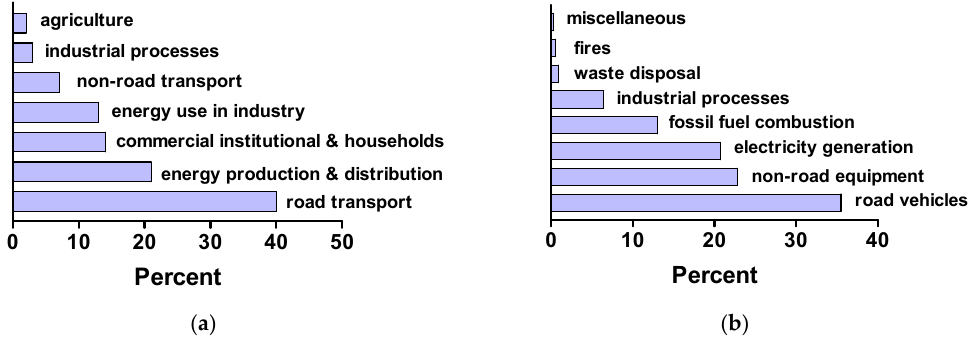
Figure 2. ( a ) Percent emission of NO x agents from various sources for 2011 in the European Union (Source: European Union emission inventory report 1990–2011 under the UNECE Convention on Long-range Trans-boundary Air Pollution (LRTAP)). Reproduced from Ref. [4]. ( b ) Percent emission of NO x agents for 2005 in the United States (Source: U.S. Environmental Protection Agency, Air Emission Sources , 4 November 2009). Reproduced from Ref.